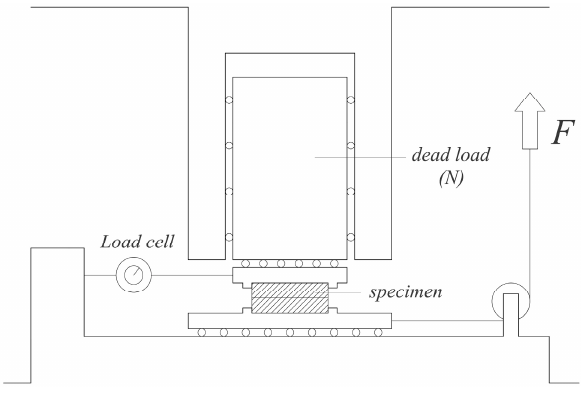
Figure 2. Friction tests scheme.